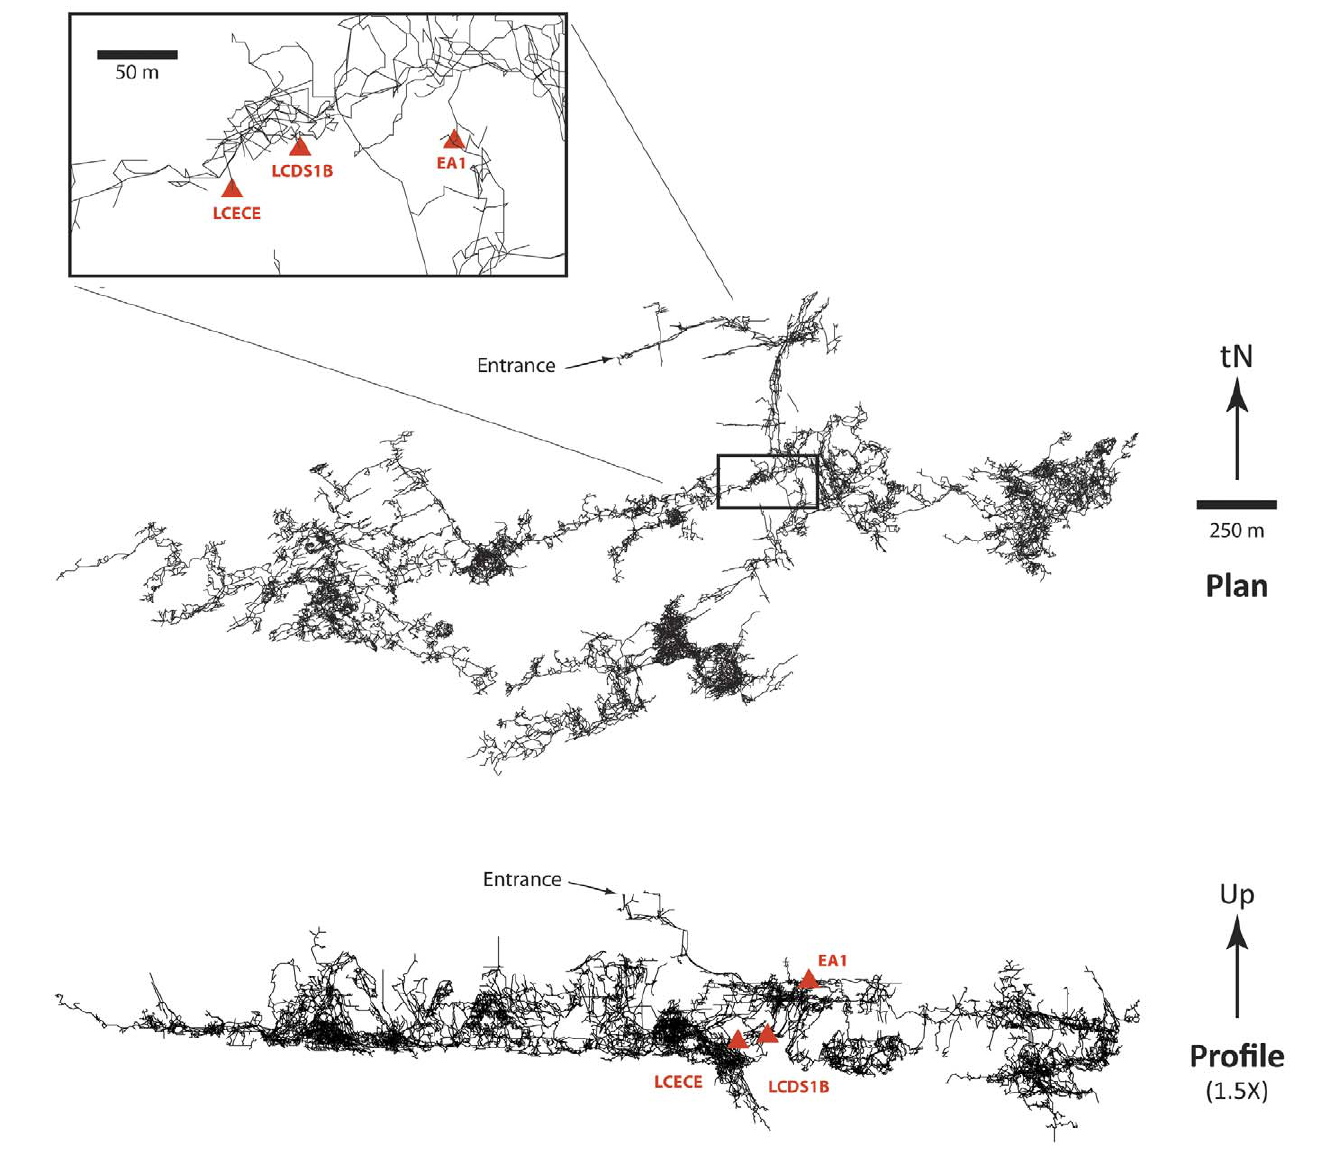
Figure 1. Plan and profile maps of Lechuguilla Cave, Carlsbad Caverns National Park, New Mexico. The sites where microbial strains were collected (LCECE, LCDS1 and LCEA1) are shown relative to the entrance and depth. tN represents true North on the plan, while the profile has an exaggerated vertical profile of 1.5 6 .